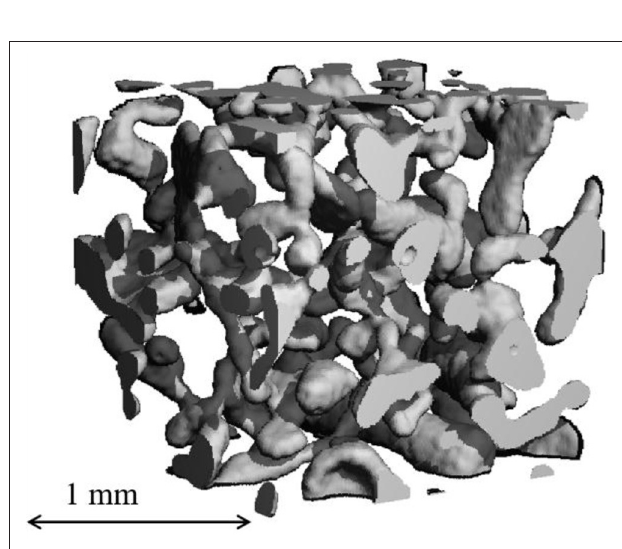
FIGURE 2 | Micro-computed tomography image of a snow sample (Snow Physics Group, SLF).